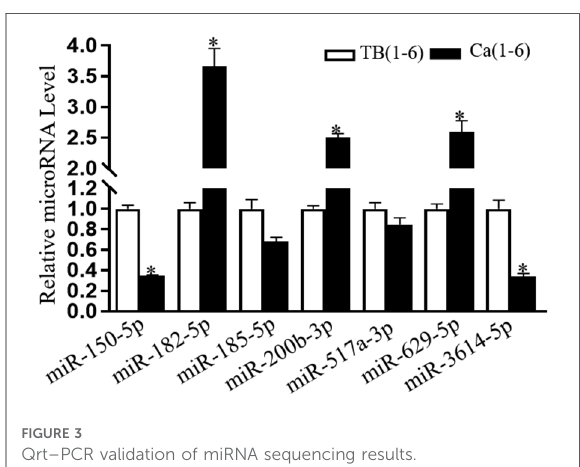
FIGURE 3 Qrt – PCR validation of miRNA sequencing